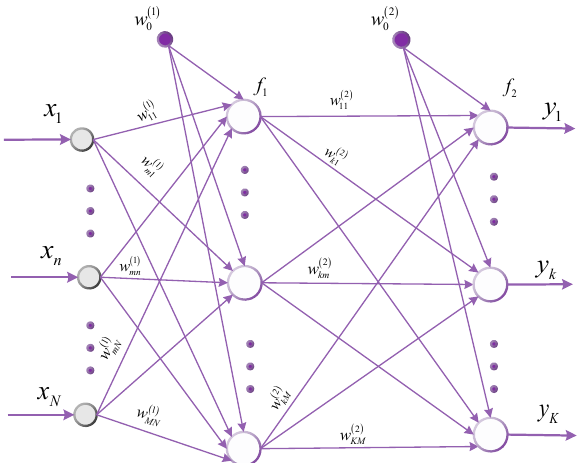
Figure 2. Example of structure of the feedforward multilayer perceptron (MLP) network.